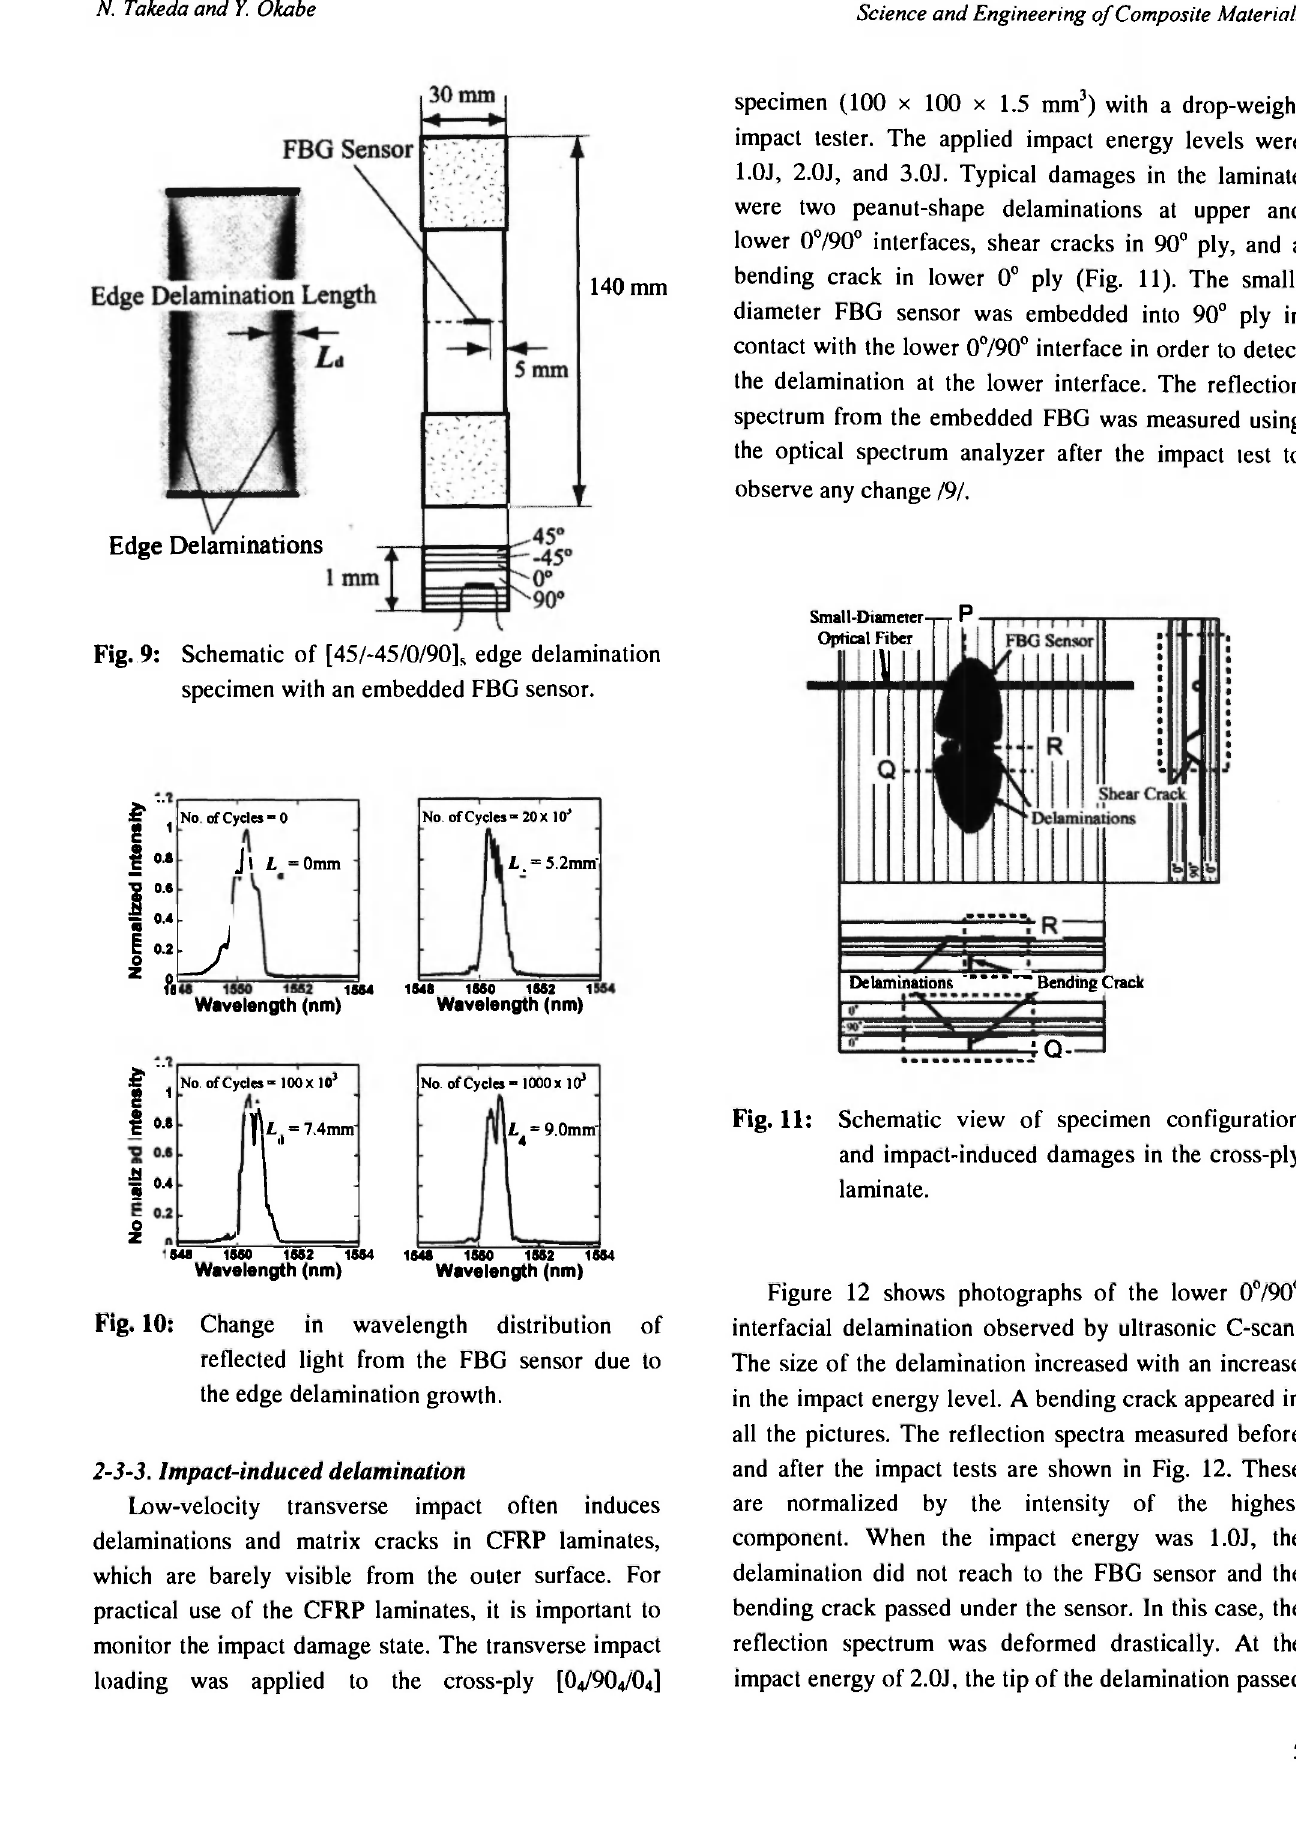
Fig. 10: Change in wavelength distribution of reflected light from the FBG sensor due to the edge delamination growth.